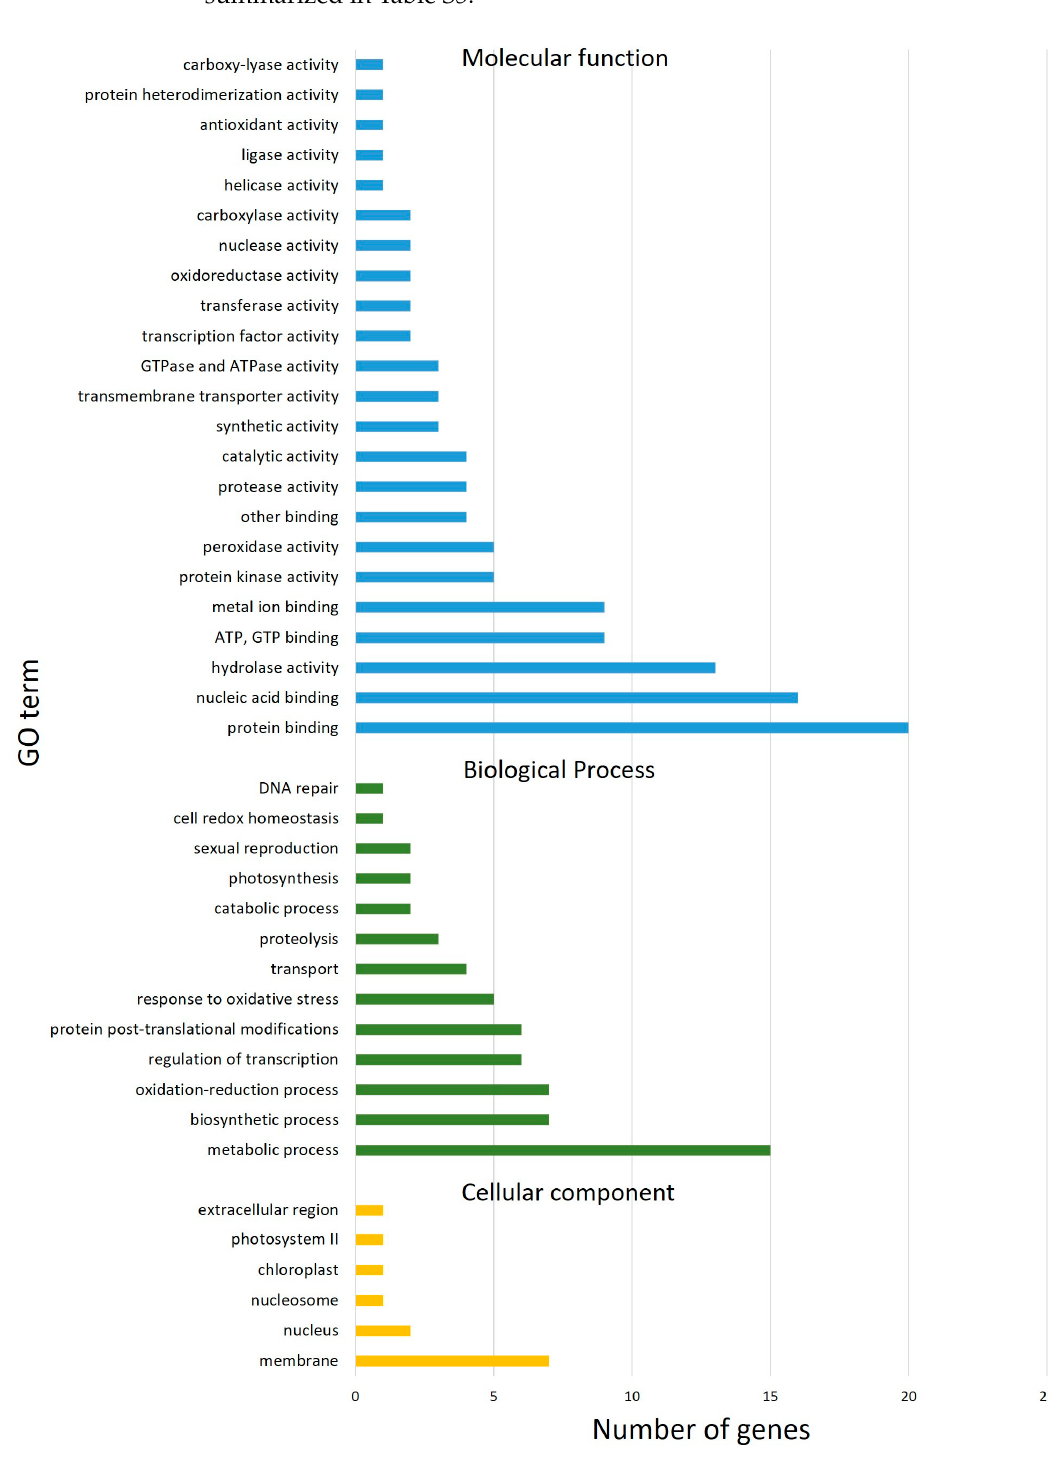
Figure 5. Gene ontology (GO) enrichment